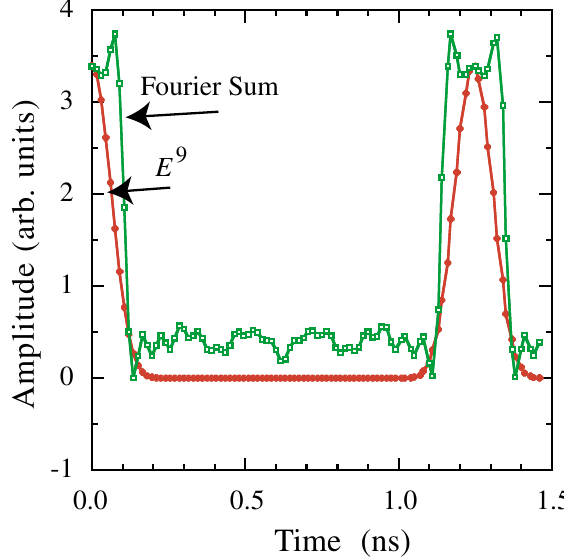
FIG. 12. (Color) The derived pulse shape from the frequency spectrum measurements.